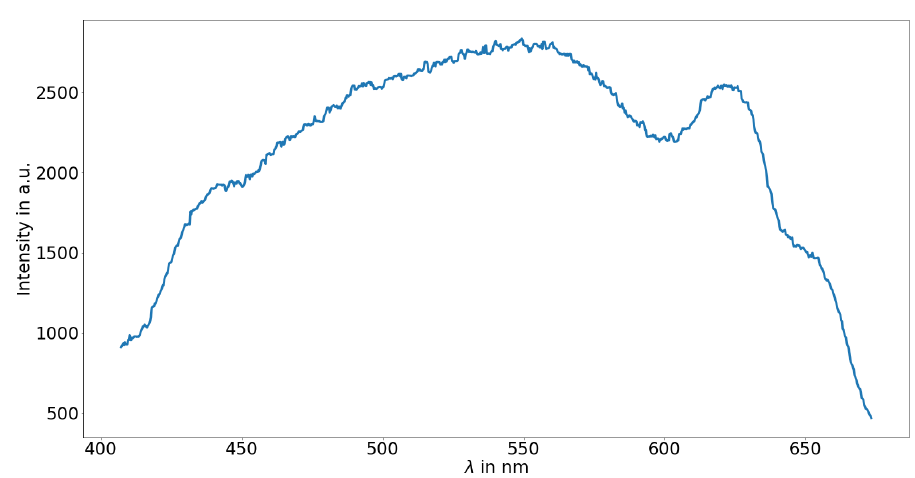
Figure A1. Reflectance spectrum from barium sulfate measured by the hyper-spectral camera before normalization. The drop of intensity in the blue and the red region is caused by the spectral efficiency of the grating and the